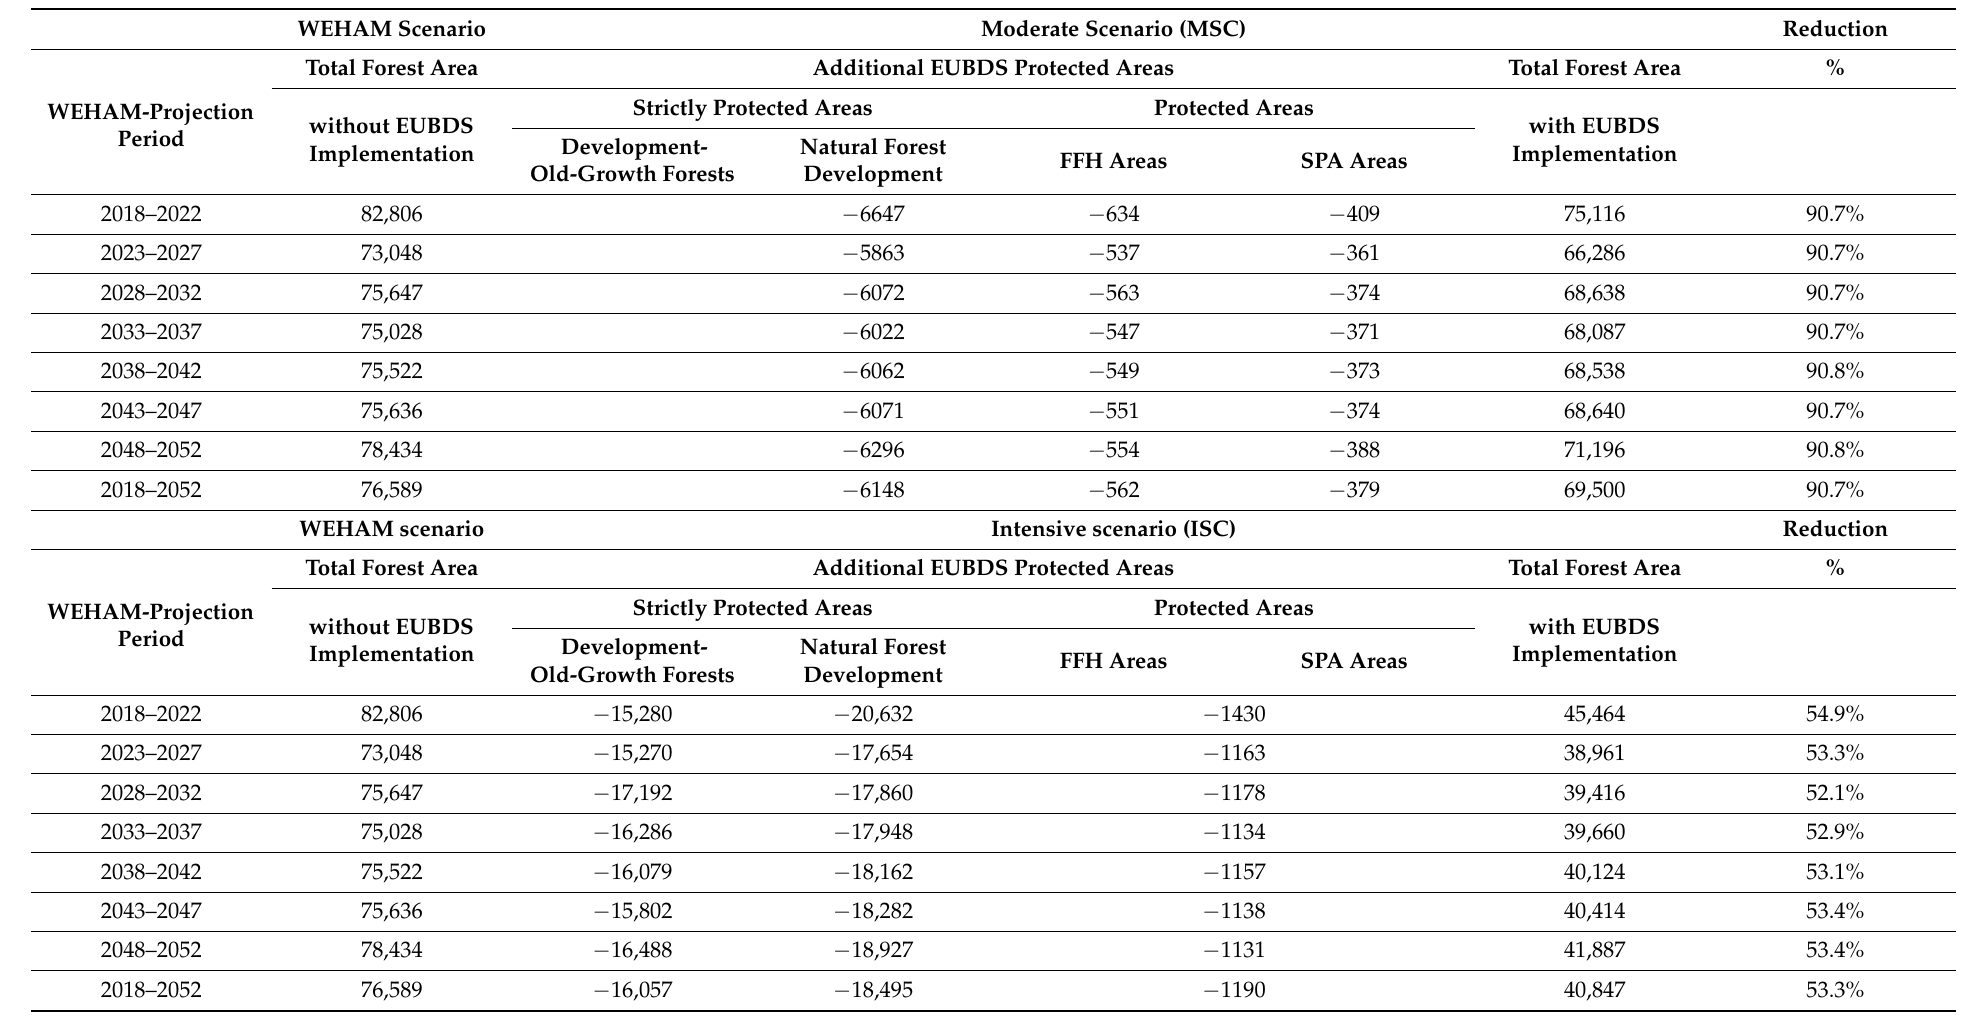
Table A6. Roundwood stocks in Germany in different forest types to determine roundwood availability for MSC and ISC (in 1000 m 3 per a) [authors’